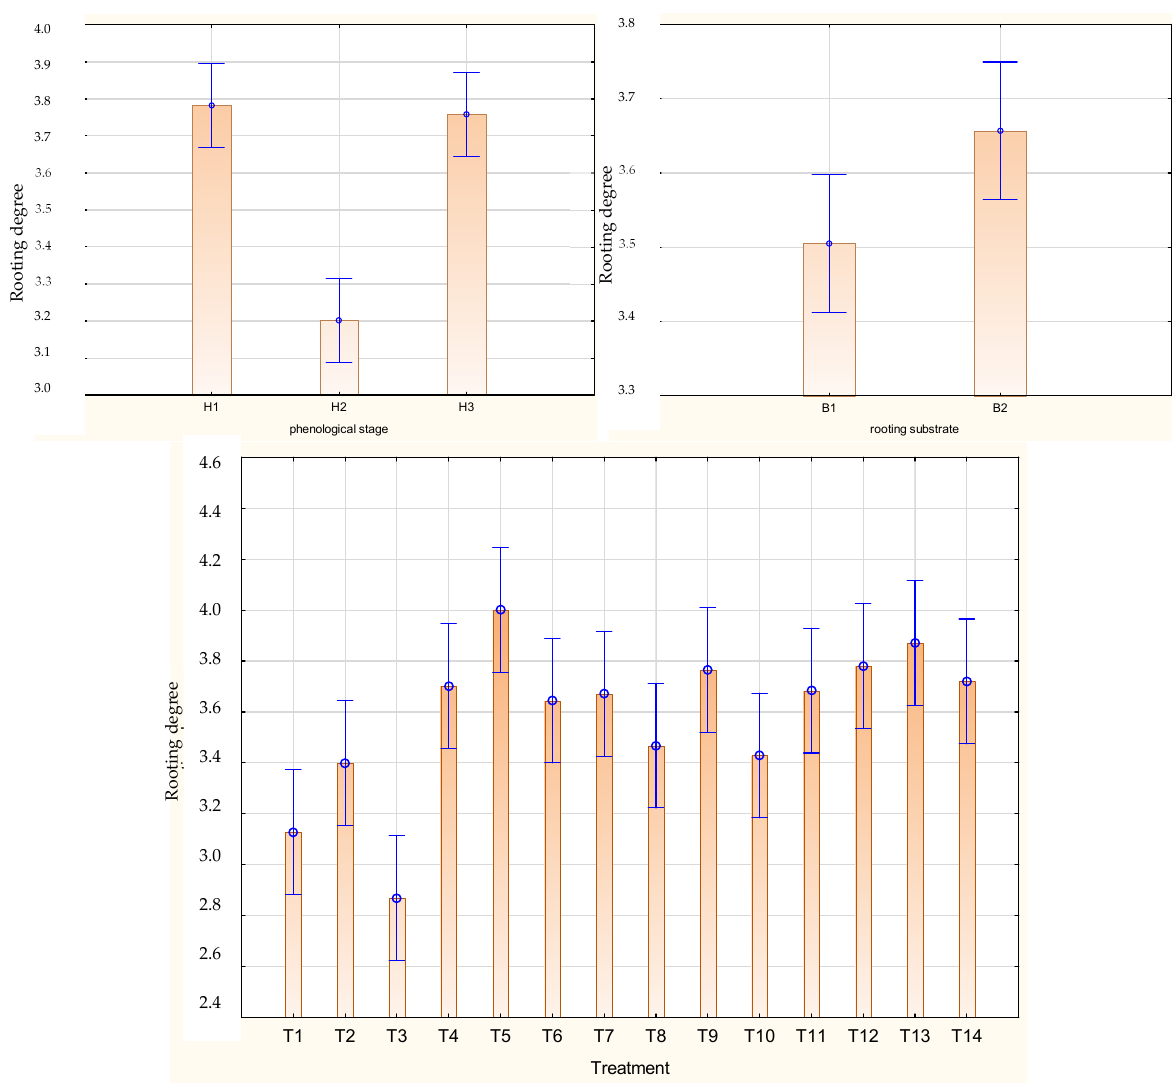
Figure 3. Rooting degree in Rosa ‘Hurdal’ cuttings prepared from three phenological stages (H1–H3) of shoots and rooted in two rooting substrates after treatment by rooting enhancers.